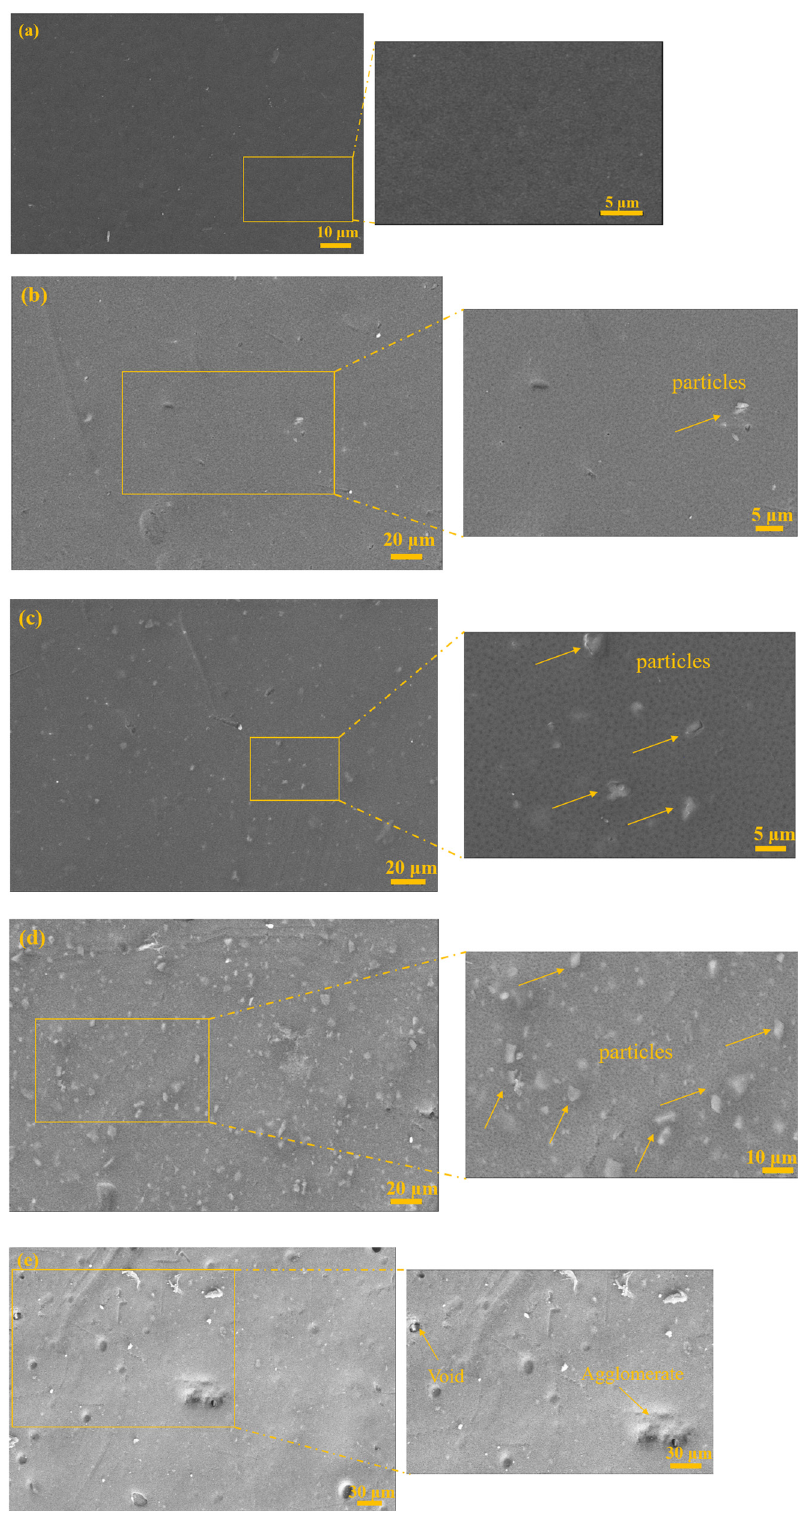
Figure 6: Surface morphology of ( a ) PES, ( b ) PES/MIL - 100 ( Al ) 5%, ( c ) PES/MIL - 100 ( Al ) 10%, ( d ) PES/MIL - 100 ( Al ) 20%, and ( e ) PES/MIL - 100 ( Al )